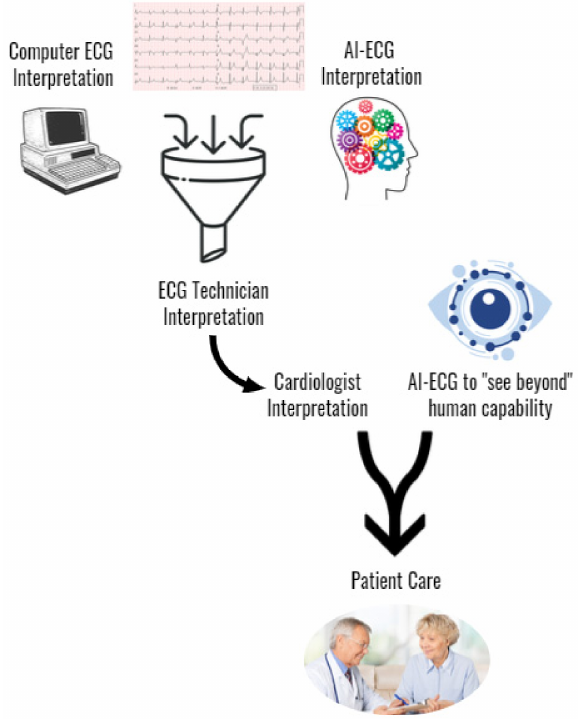
Figure 3. Proposed incorporation of AI-ECG into the clinical